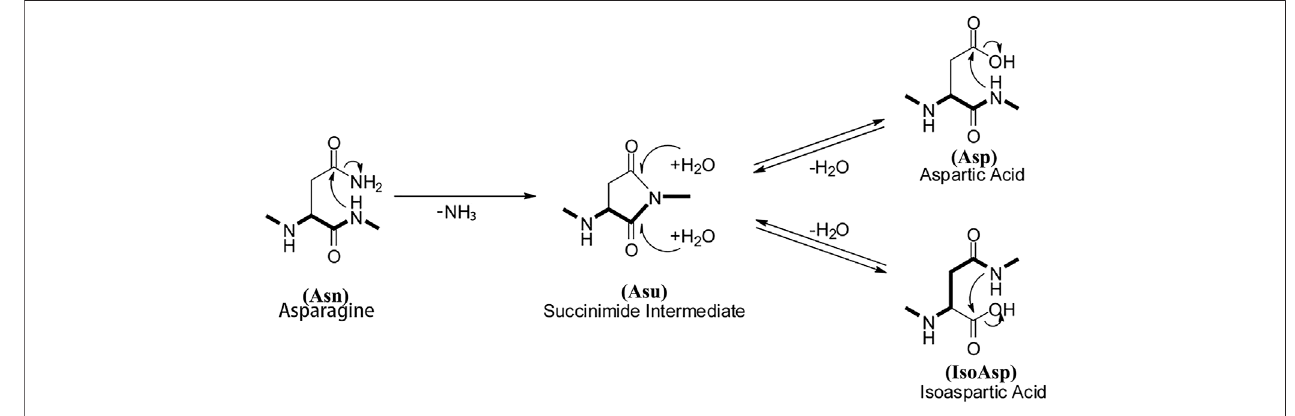
FIGURE 1 | Schematic representation of deamidation